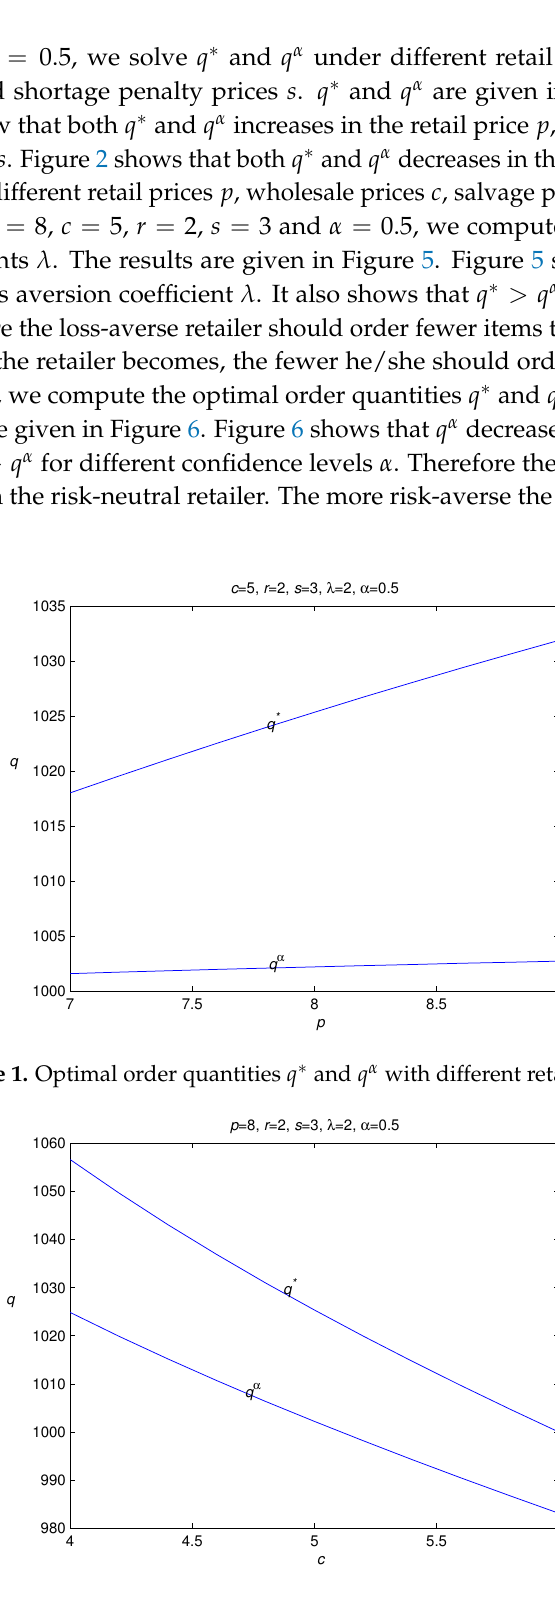
Figure 2. Optimal order quantities q ∗ and q α with different wholesale prices c